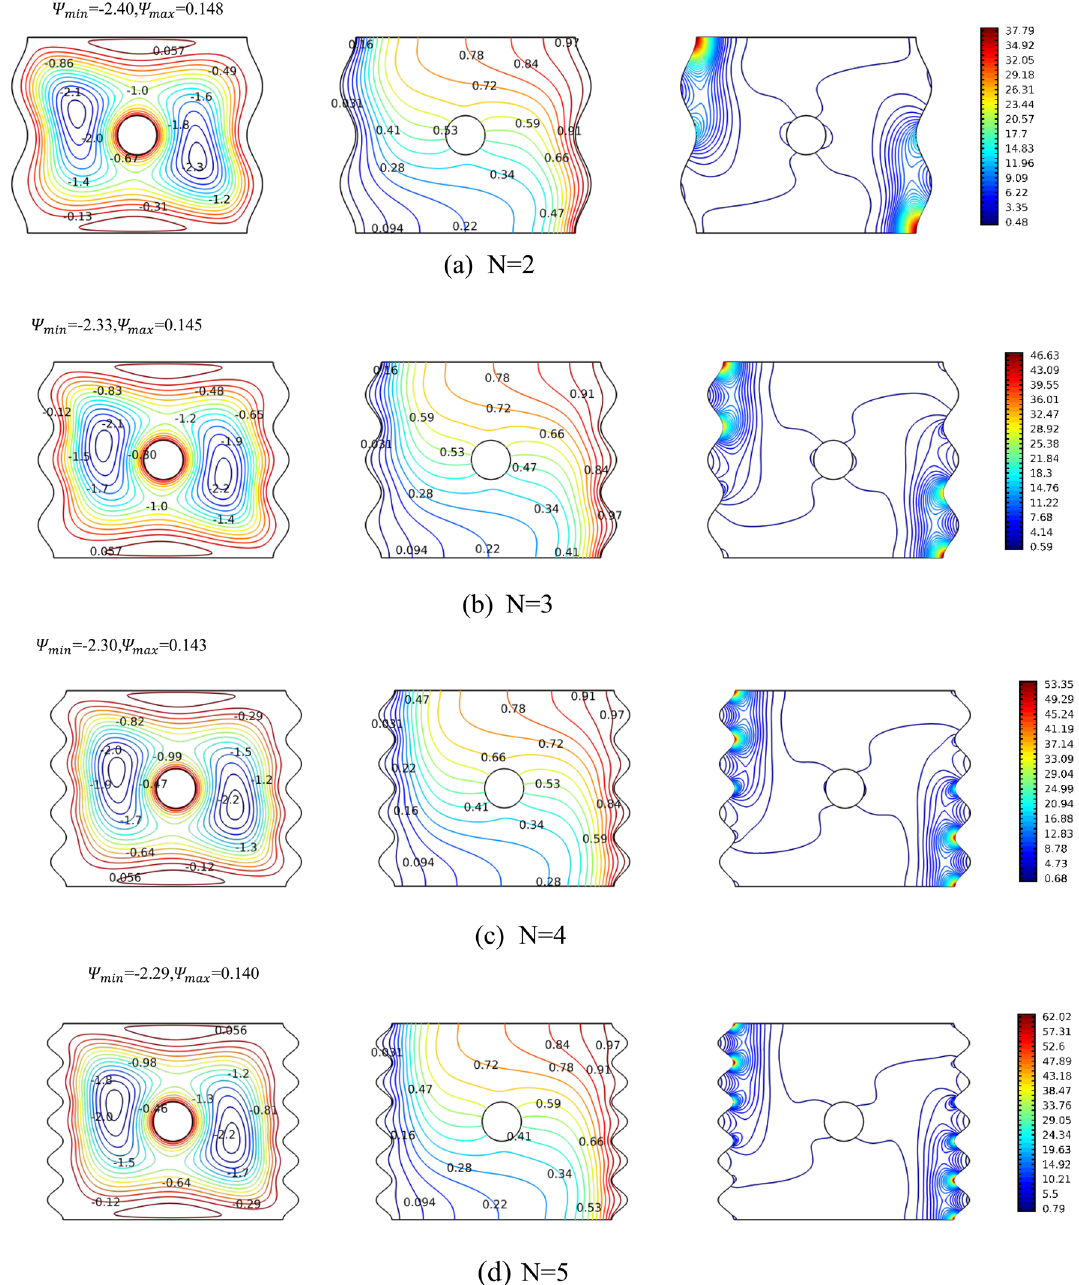
Figure 3. Streamlines, temperature contours and isentropic variation for various undulations (N) for case Ra = 10 4 , Ha = 0, Ω = 0. The panels represent the levels of the for Ra = 10 6 where the convection mode of heat transfer is dominant and just at the end boundary of laminar flow, the effect of the rotating cylinder and the magnetic field is local. All of this, especially the rise of vortices near heat source and sink predicts enhanced heat transfer. Therefore, one can observe the isotherms (middle column in Fig. 4) evenly distributed over the cavity for low Ra, whereas it takes the shape of the most affecting heat transfer for high Ra, where the isotherms lines are highly dense near the hot and cold sides and scarce towards the middle of the cavity, which increases the thermal gradient; the driving force of the heat transfer. The isentropic contours iterate identical tale. As mentioned previously, the generated irreversibility is com- prised of 3 components: heat transfer, nanofluid friction, and magnetic effect. At low Ra values, the three com- ponents are comparable and hence the isentropic lines span the entire cavity. However, with increased Ra. the heat transfer component becomes the dominant and thus the isentropic contours are converging to the active (thermally) sides and disappearing from the middle.